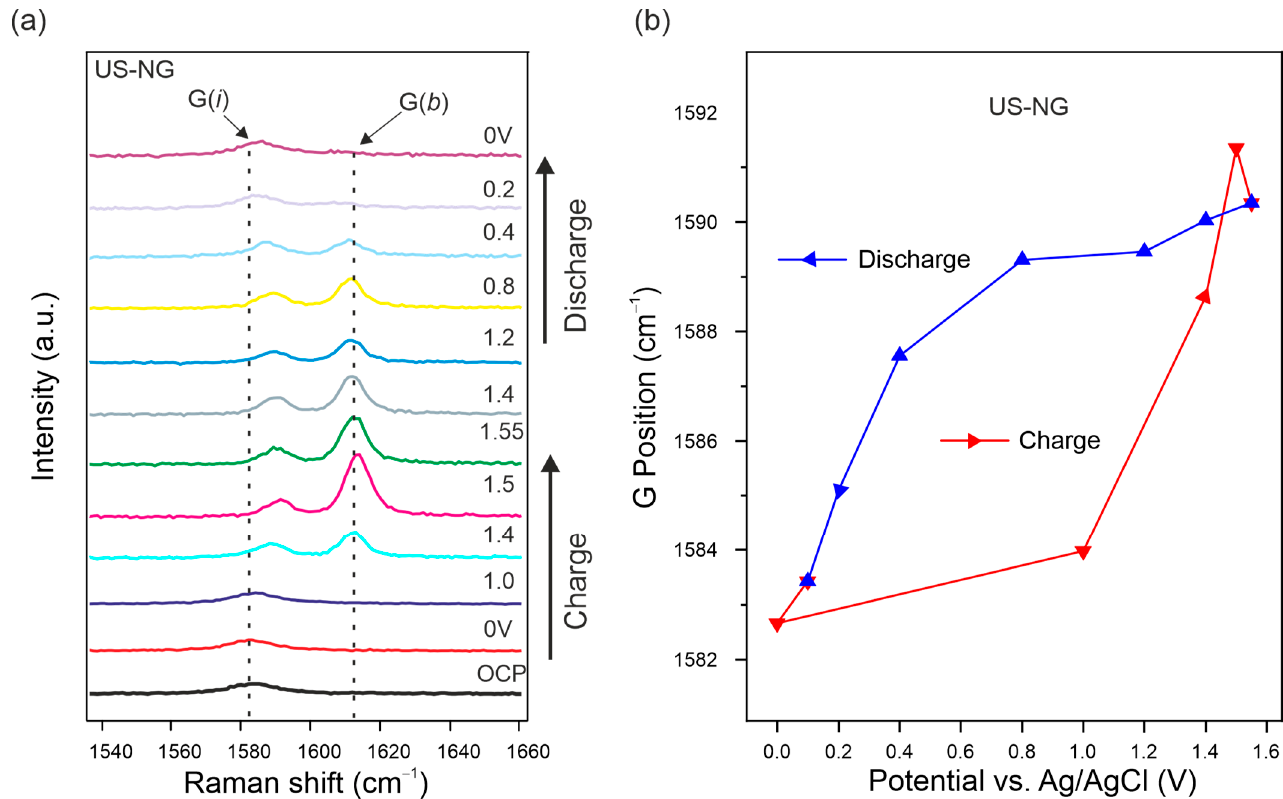
Figure 3. In situ Raman SEC of US ‐ NG during charge/discharge cycle in 2.4 M Al(ClO 4 ) 3 aqueous electrolyte. ( a ) Evolution of the Raman spectra in the G peak spectral region. ( b ) Raman G peak position evolution fitted as one Lorentzian line shape. The applied potentials were held for 1000 s for each step.